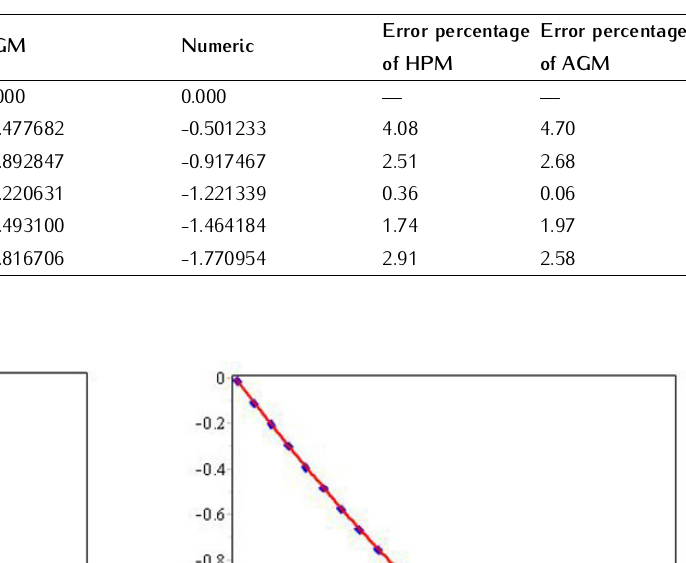
Table 3. Comparing the obtained values for f ( η ) by HPM and AGM with the numerical solution.